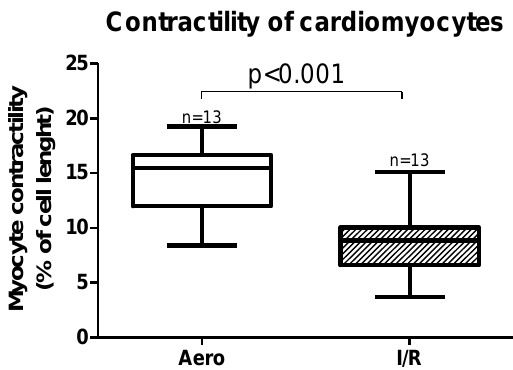
Figure 1. Myocytes contractility after ischemia and in aerobic conditions. Aero—aerobic control group, I/R—ischemia/reperfusion group; all data are expressed as mean ± SEM. Lactate dehydrogenase (LDH) activity measured in coronary effluents was significantly increased in the I/R group in comparison to the Aero group ( p = 0.01, n = 5–7) (Figure 2), confirming cardiomyocyte damage during I/R.